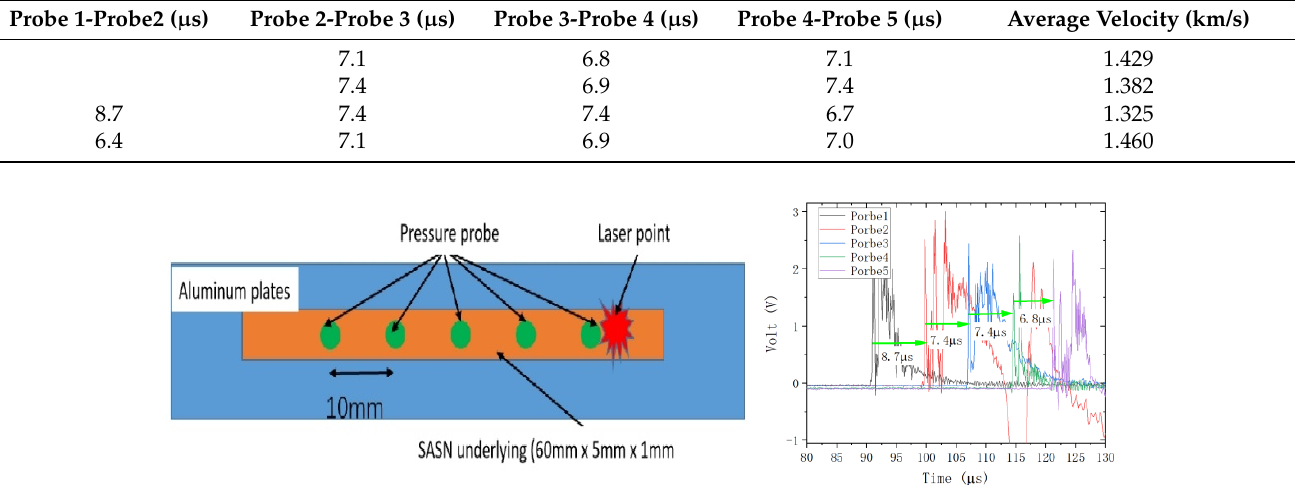
Table 5. Detonation velocity measurement results.